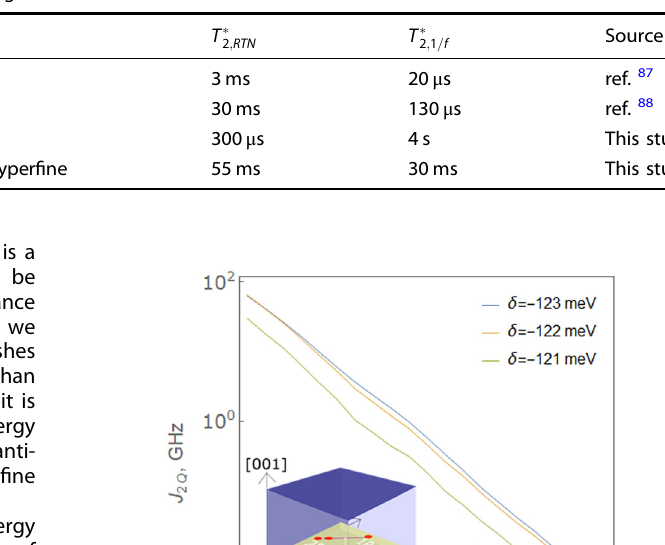
and 1/ f noise T (cid:3) for QD single-spin qubits, 2P:1P qubit at the charge 2 ; RTN 2 ; 1 = f